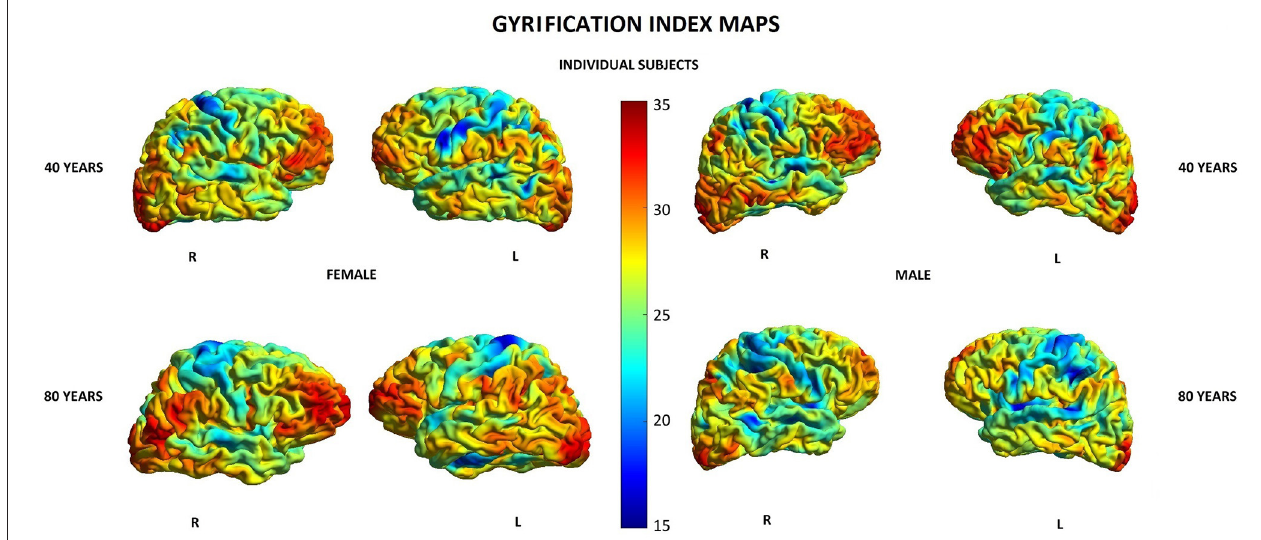
FIGURE 4 | Cortical maps of age-related distribution of gyrification index in 40- and 80-year-old female and male individual subjects. Lateral views of right (R) and left (L) hemispheres.